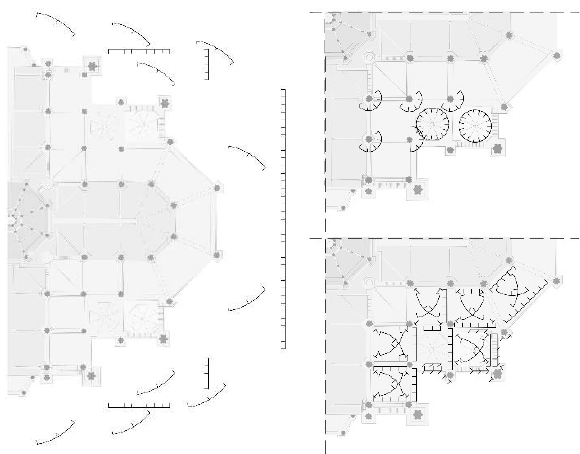
Figure 4. network geometry used to survey the apse, on the left the network followed on the ground, and on the right the network of the